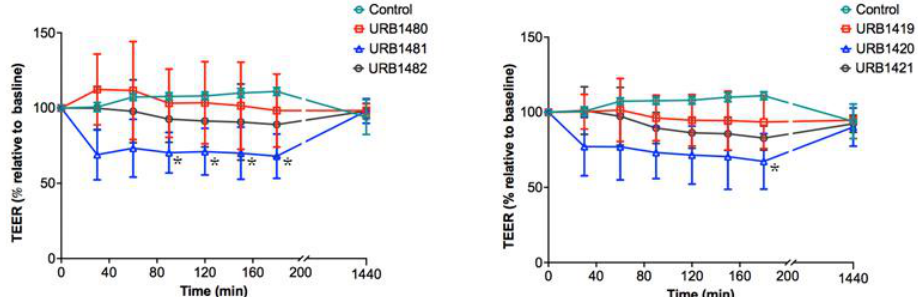
Figure 4. TEER study of sucrose-based surfactants (URB1480-URB1482) and lactose-based surfactants (URB1419-URB1421) at a concentration of 4 mM on Calu-3 monolayers. The values reported are the mean ± SD of three independent experiments. * p < 0.05 vs. control (Student’s t -test).